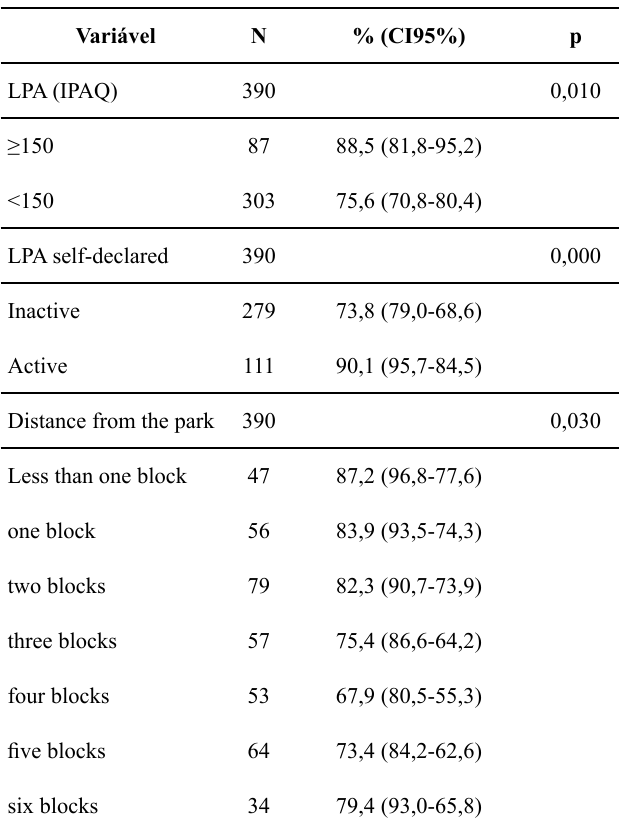
Table 2. Frequency of individuals who intend to use the park to prac- tice physical activity, according to the level of physical activity in leisure estimated by IPAQ and self-declared, and by the distance from the